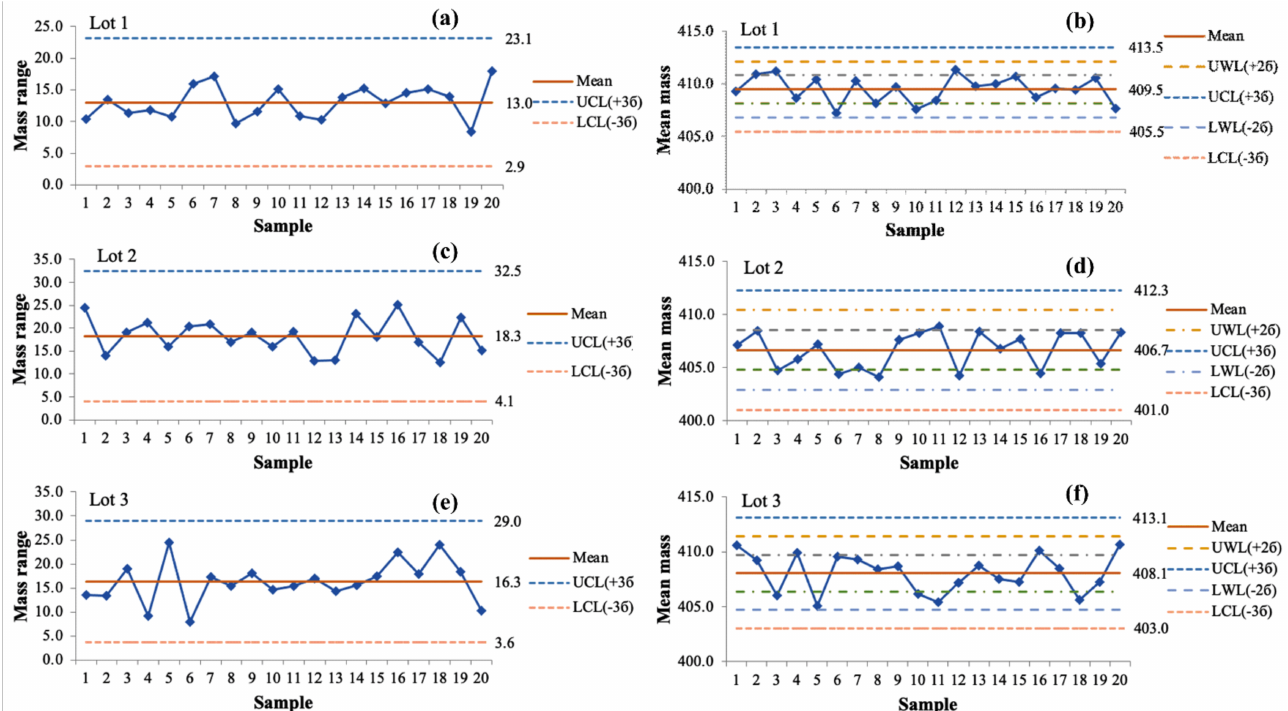
Figure 1. Shewhart mass range (R) and mean mass ( X ) diagrams of tablet mass of three batches. ( a , b ) Shewhart R/ X chart of lot 1, ( c , d ) Shewhart R/ X chart of lot 2, ( e , f ) Shewhart R/ X chart of lot 3. Table 8. Results of the investigated Shewhart R chart for the tablet weight of three batches. Rule Request (Not